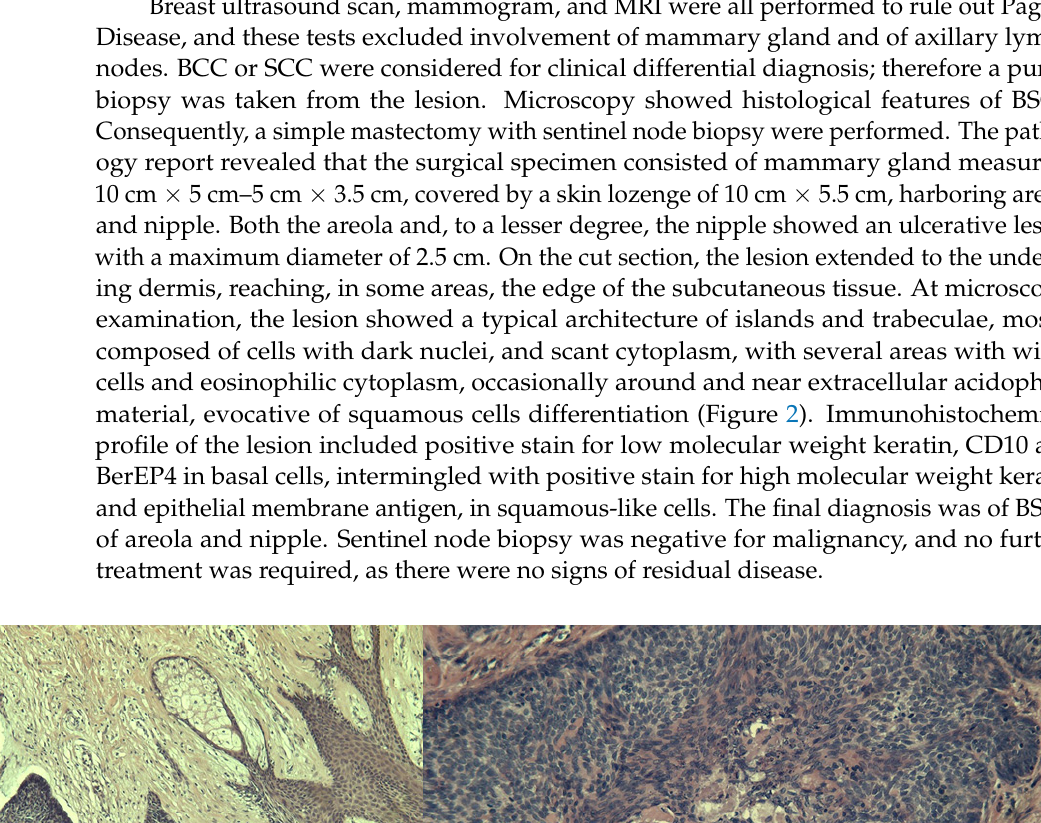
Figure 1. Enlarged left nipple ‐ areola complex. Clinical appearance of BSCC on the nipple. Erosion on the surface represents the biopsy site. Dermoscopy showed absence of a pigment network and the presence of arborizing vessels, large blue ‐ gray ovoid nests, multiple blue ‐ gray globules, leaf ‐ like areas, spoke wheel areas, and ulceration.